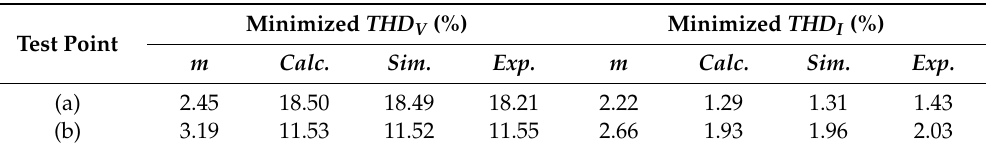
Table 2. Minimized voltage and current THD s—specific cases.